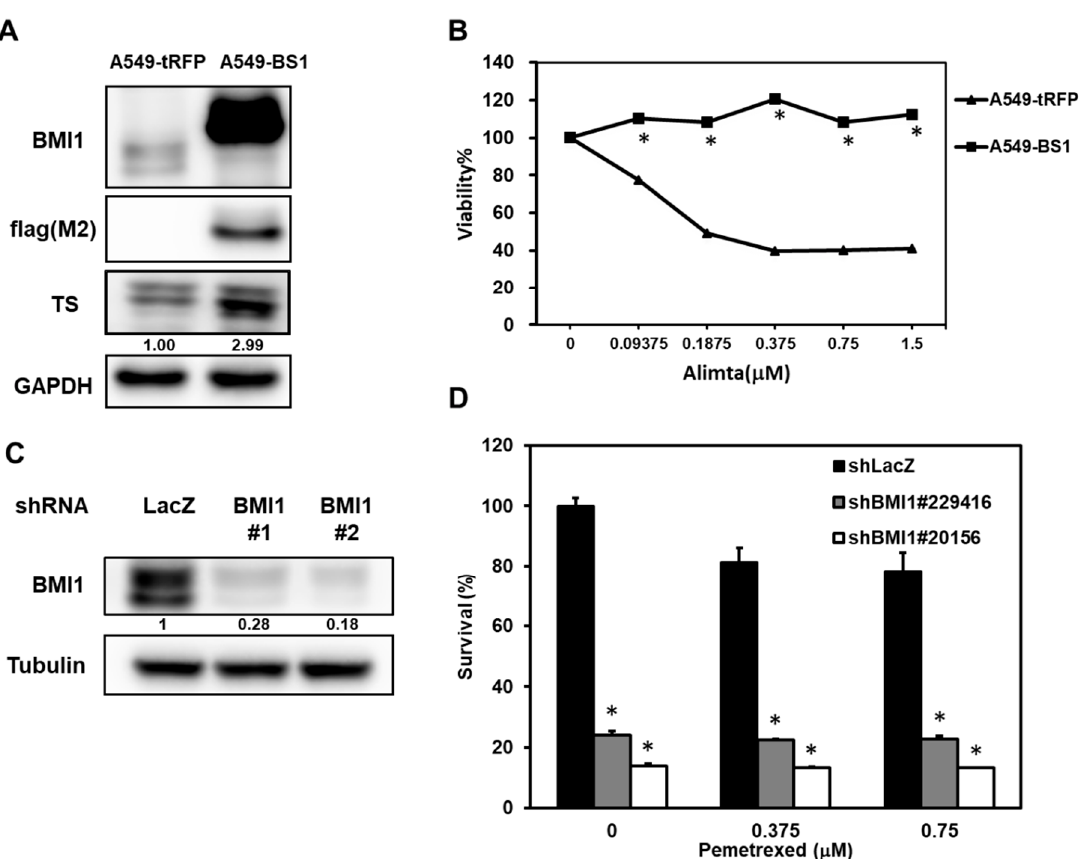
Figure 3. Manipulating BMI1 expression in NSCLC cells influences the pemetrexed sensitivity. ( A , B ) A549 cells were transduced with lentiviruses of tRPF control (A549-tRFP) or flag-tagged-BMI1 (A549-BS1) and selected with 20 µ g / mL blasticidin S for 96 h. The expressions of flag tagged-BMI1 and TS in A549-tRFP or A549-BS1 were examined by western blot ( A ). The pemetrexed sensitivity of A549-tRFP or A549-BS1 cells were determined by MTT assay ( B ). * p < 0.05. ( C , D ) A400 cells were transduced with lentiviruses carrying sh-LacZ or sh-BMI1 (#1 or #2) and selected with 2 µ g / mL puromycin for 48 h. The survived cells were harvested and BMI1 expression was examined by western blot ( C ) or pemetrexed sensitivity was examined by MTT assay ( D ). * p < 0.05. All the experiments were done three times and data from one experiment were presented.